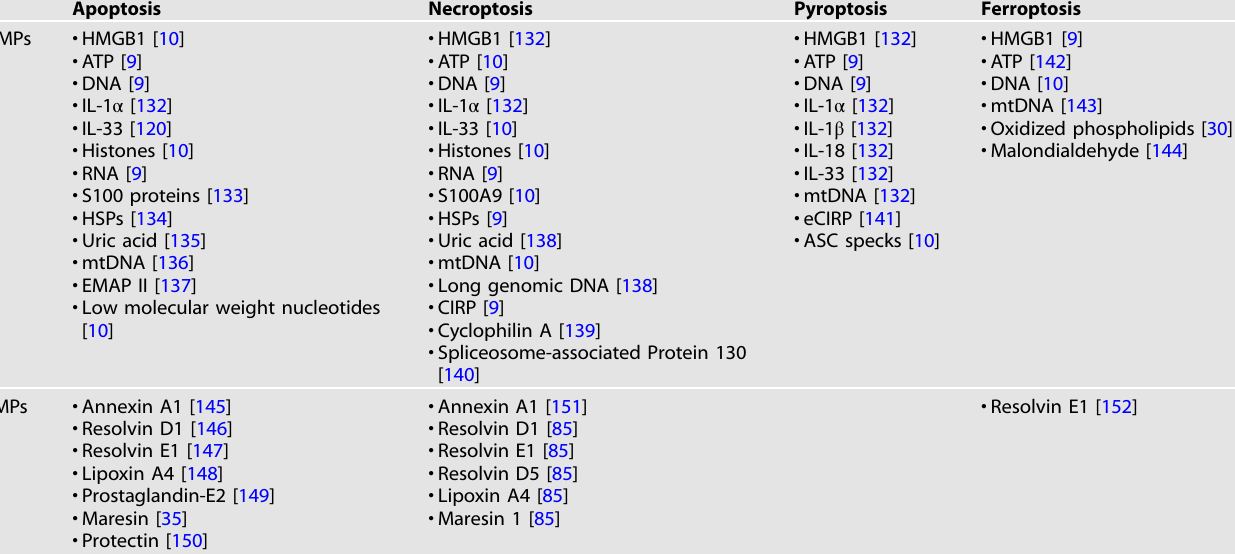
Table 3. Pros and cons of different forms of necroin fl ammation. Pros Cons Cell death modalities differ in the mechanism of DAMP release Each cell death process can be activated by multiple Different DAMPs are released during cell death modalities Timely different DAMPs can be released in the same Critical DAMPS of the Th differentiation, such as IL-1, IL-33, SAMPs seems to be produced dominantly upon speci fi c cell death forms. Different posttranslational modi fi cations of DAMPs are activated upon different cell death pathways